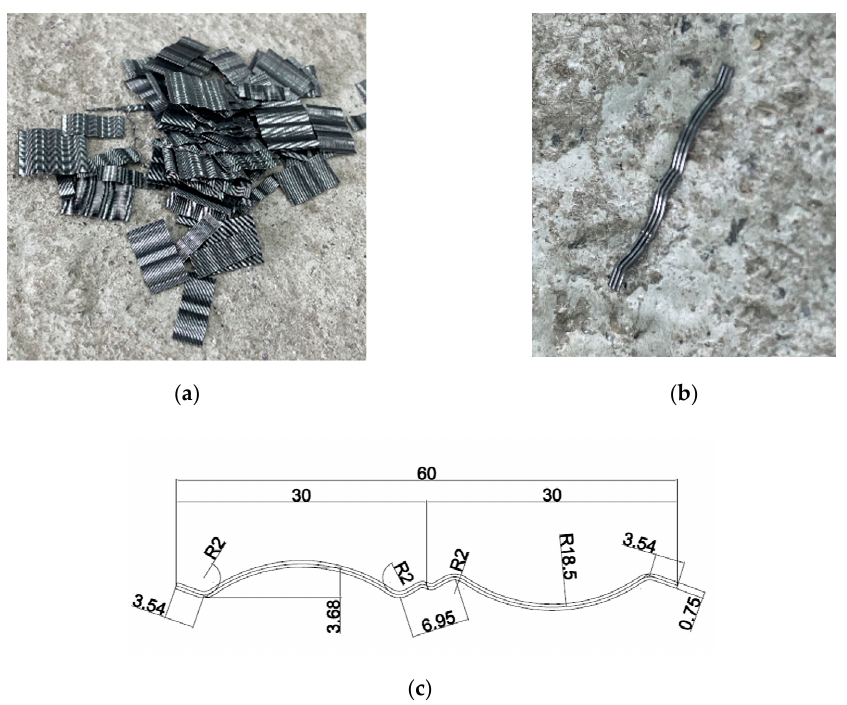
Figure 3. Steel fibers: ( a ) Before dispersion; ( b ) After dispersion; ( c ) Section details (mm).